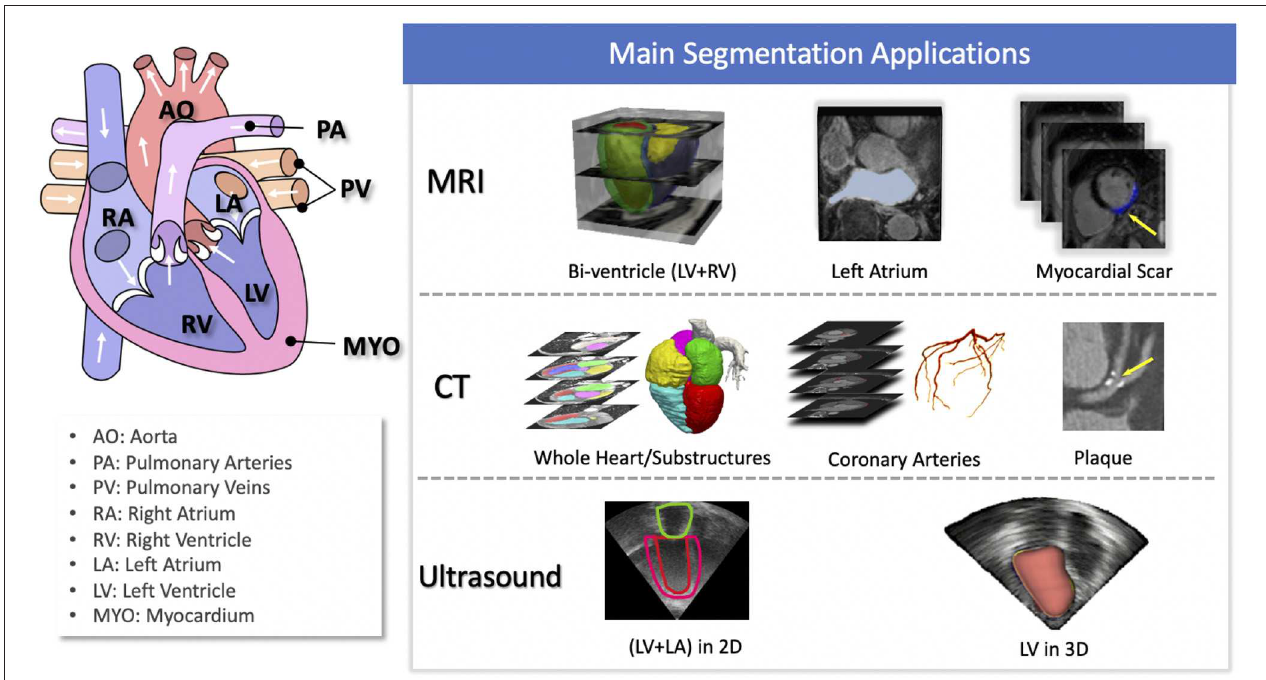
FIGURE 1 | Overview of cardiac image segmentation tasks for different imaging modalities. For better understanding, we provide the anatomy of the heart on the left (image source: Wikimedia Commons, license: CC BY-SA 3.0). Of note, for simplicity, we list the tasks for which deep learning techniques have been applied, which will be discussed in section 3.